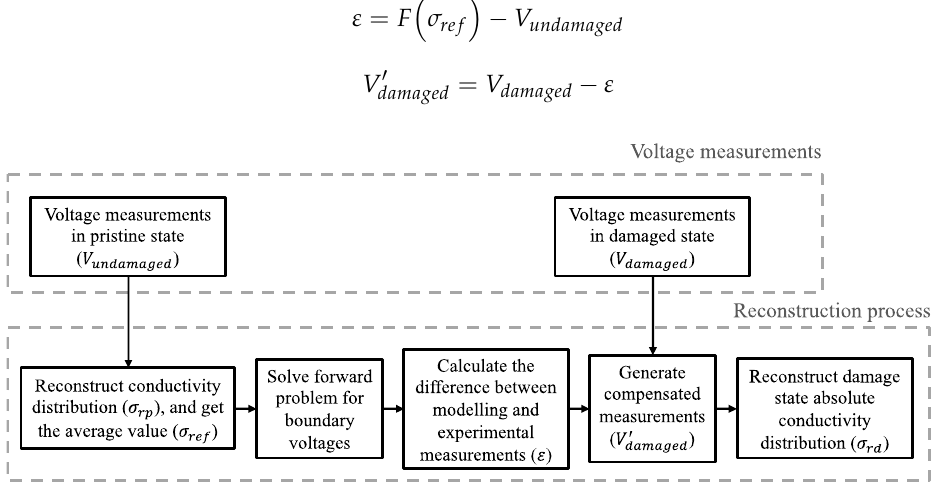
Figure 1. The flow chart illustrates the adjusted absolute imaging process.